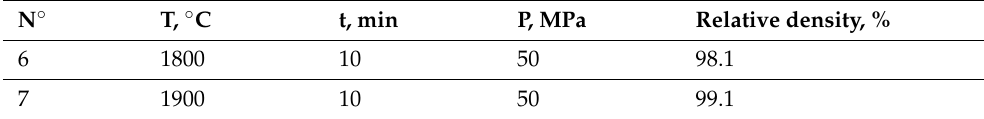
Table 2. Consolidation conditions and properties of preliminary cold-pressed bulk boron carbide. N°